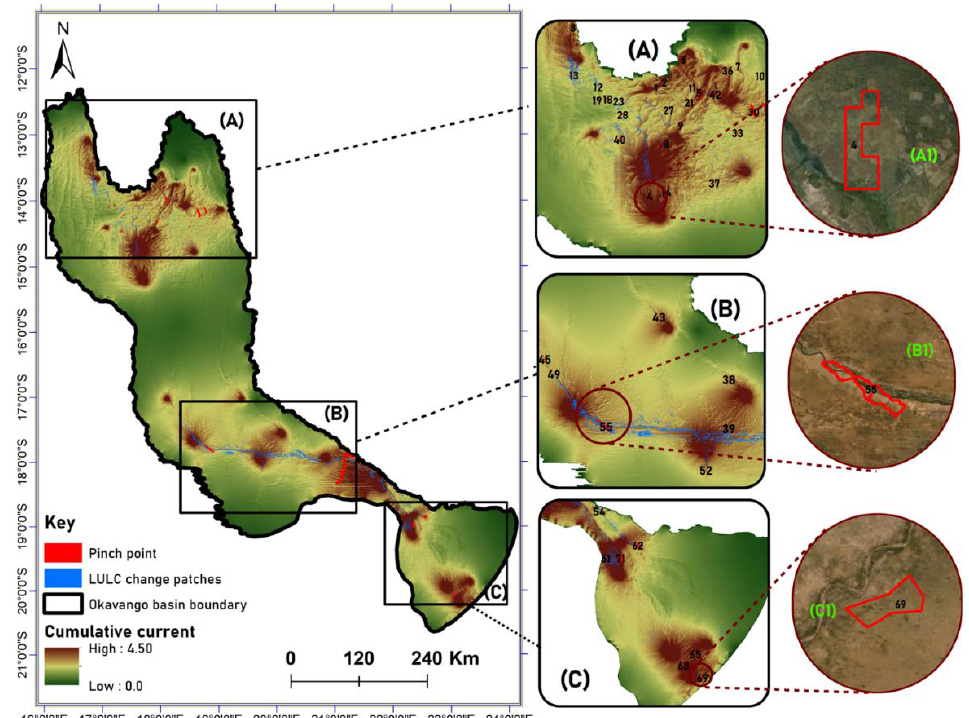
Figure 7. The map shows the cumulative current map and pinch points for Category B transitions (from artificial to natural classes). The subfigures ( A ) – ( C ) highlight areas of the basin with high cumulative current density and subfigures ( A1 ) – ( C1 ) indicate locations of selected pinch points overlaid on satellite images to show how pinch points appear on the ground.